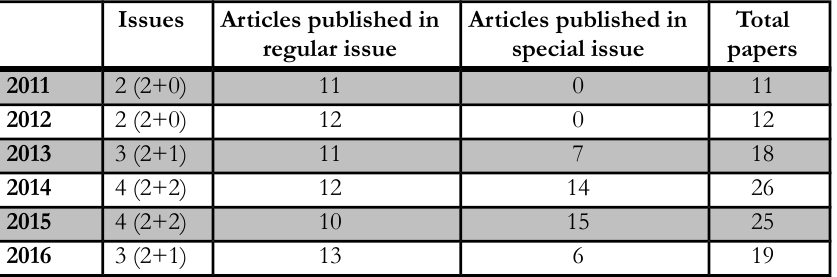
Table 2. Number of Articles published